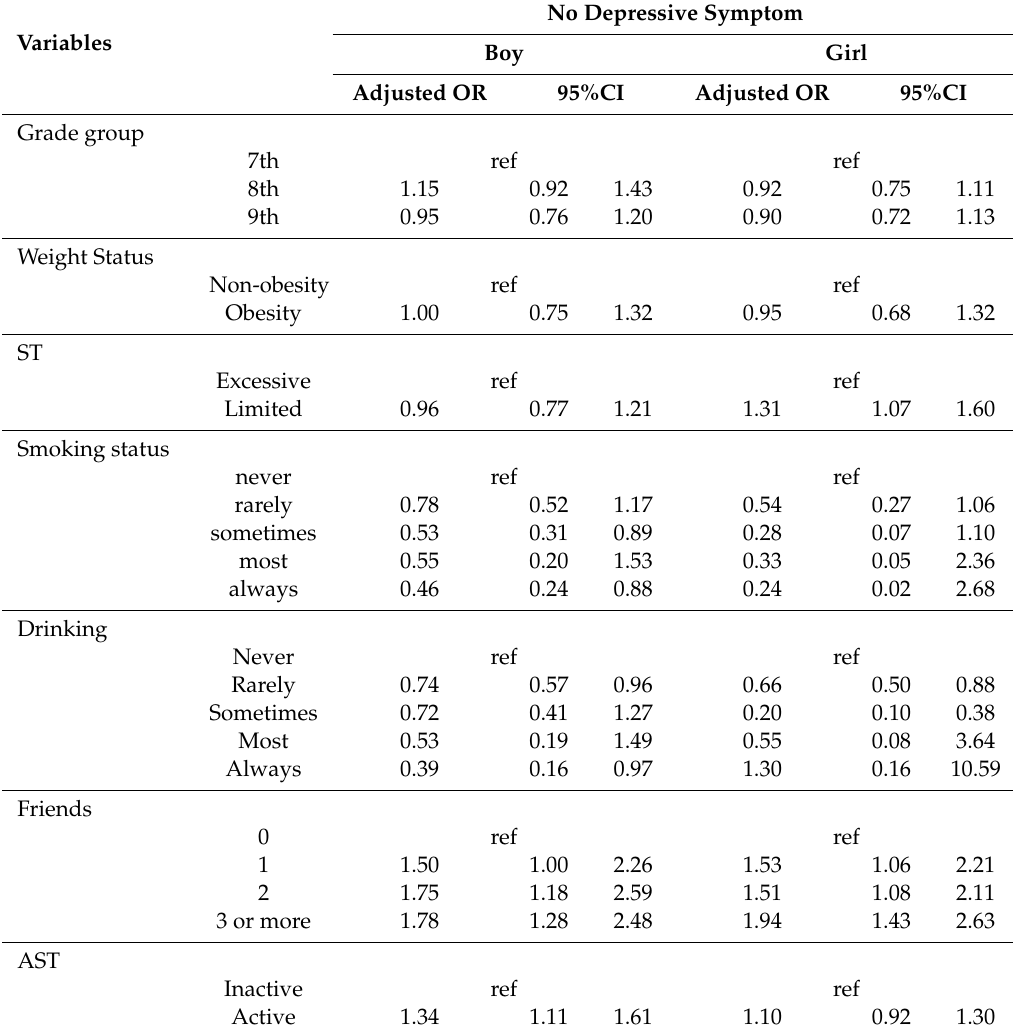
Table 4. Relationships of AST and control variables with no depressive symptom by sex.